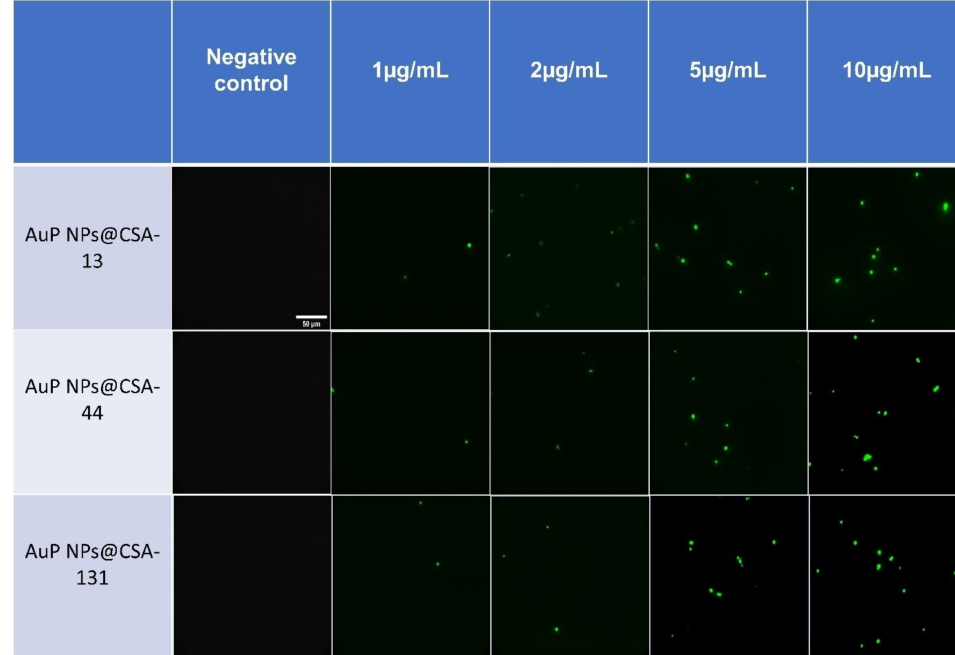
Figure 5. Generation of reactive oxygen species in AuP NPs@CSA-13, AuP NPs@CSA-44, and AuP NPs@CSA-131 -treated Candida cells. Increase in dichlorofluorescin diacetate–derived fluorescence signal after 1 h of treatment of C. albicans 1408 isolate with tested compounds in concentrations ranging from 1 to 10 µ g/mL.